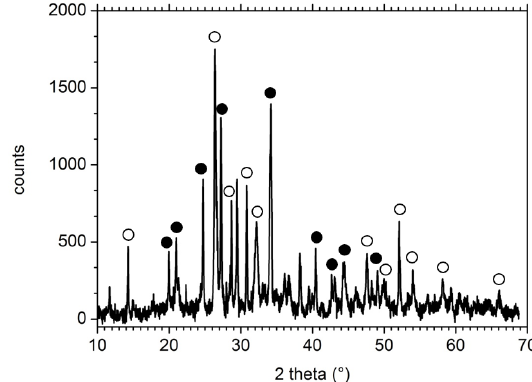
Figure 3. Diffractogram of the preparation layer of sample A. The peaks of minium (Pb 3 O 4 ) and white lead (2PbCO 3 Pb(OH) 2 ) are marked by empty and filled circles, respectively. The whole ToF-SIMS spectrum of sample A (not shown), measured on a 500 × 500 µm 2 area,